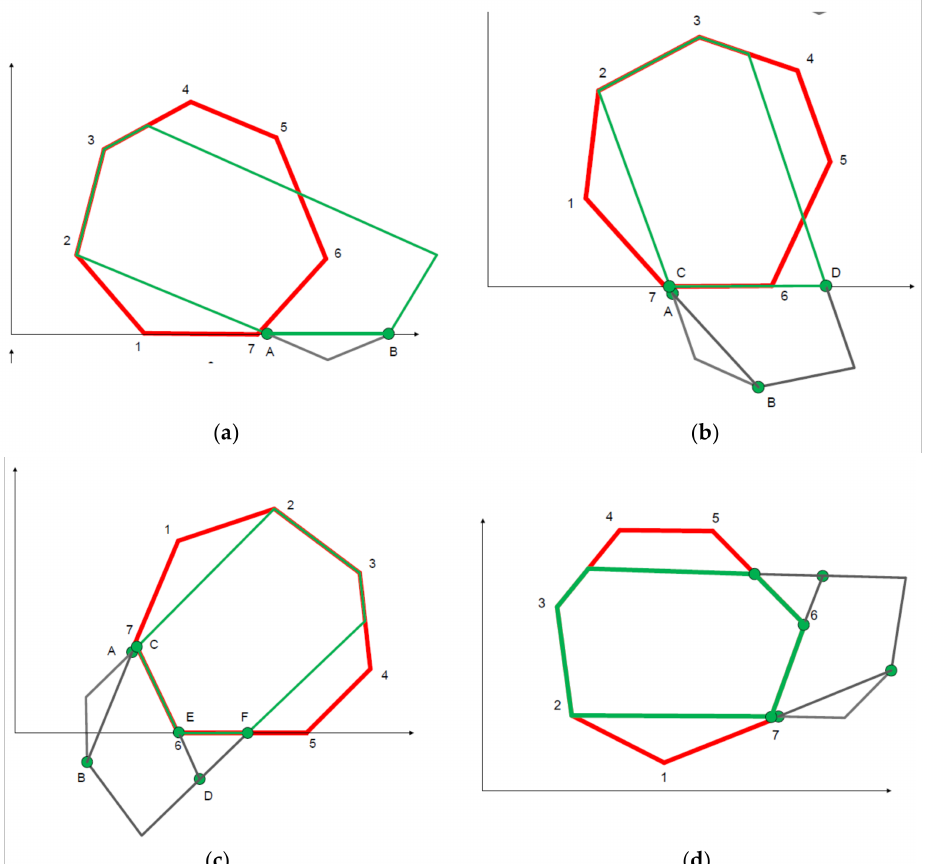
Figure 19. The search for points of horizontal axis intersection with the clipped polygon: ( a ) first rotation, ( b ) second rotation, ( c ) third rotation, ( d ) returning the polygons to their initial positions. A, B, C, D, E, F—temporary points of intersection of the polygon and the horizontal axis at different angles of rotation.